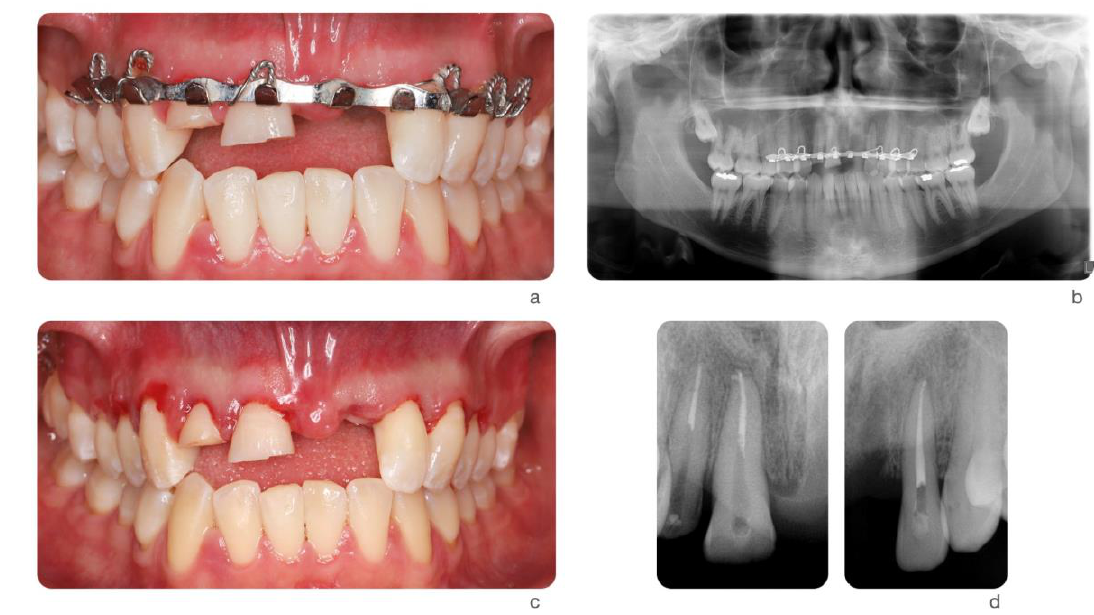
Figure 2. Ski accident that involved a 26-year-old male. He was treated in the emergency room with a metal retainer anchored with orthodontic wire around teeth involved in the trauma ( a ). The diagnosis was non-complicated maxillary fracture and teeth #7, 8, and 10 concussion and #9 avulsion. Panoramic image of the metal retainer ( b ). After 1 month of healing, metal retainer was removed ( c ) and teeth #7, 8, and 10 diagnosed as necrotic. Root canal treatments were performed ( d ).